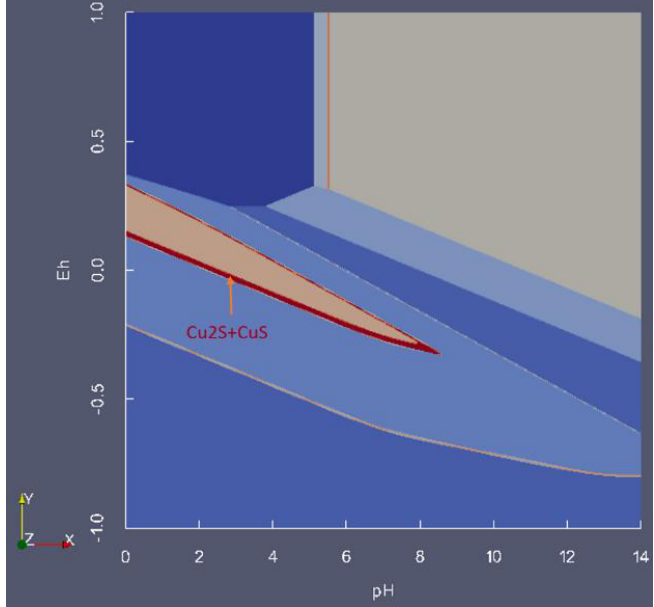
Figure 37. ParaView of Cu–S–water, where Σ Cu = 0.001 and Σ S = 0.0011 M. See the 2D plot of Figure 12 for a comparison.